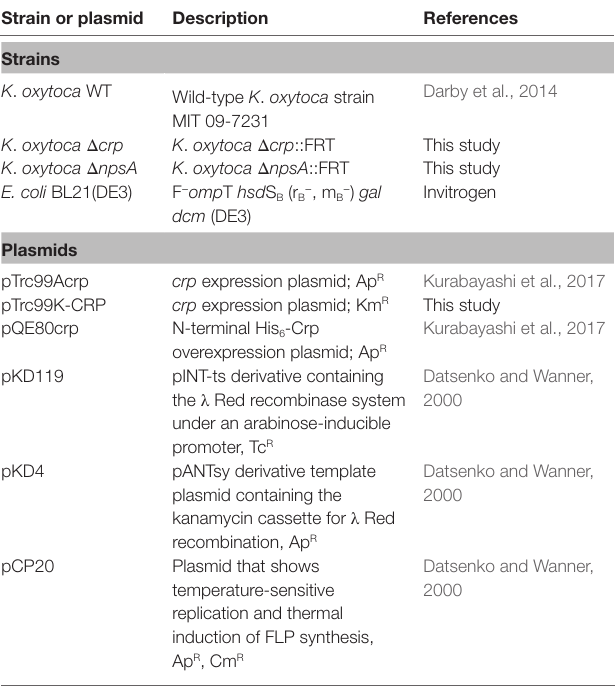
TABLE 1 | Bacterial strains and plasmids used in this